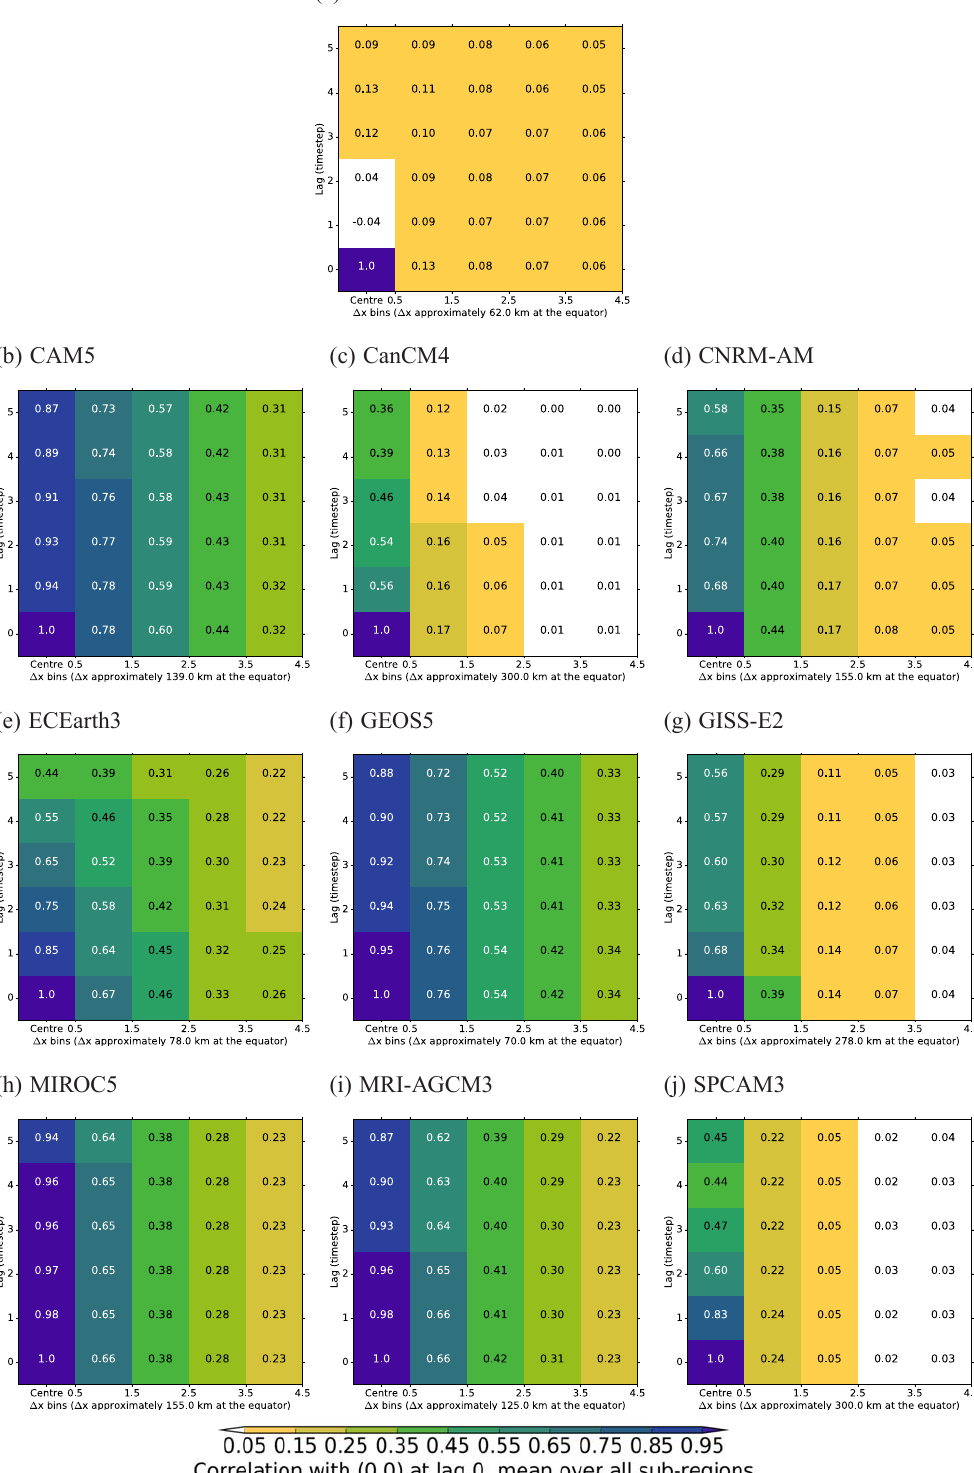
Figure 5. For each model in the GASS/YoTC dataset and using time step precipitation data on the native model grid, lagged correlations between the central gridpoint in each 7 × 7 region and gridpoints within each range of distance on the horizontal axis (in units of (cid:49)x ) away from the central point, averaged over all 7 × 7 regions. The printed values and filled blocks show the same data; “centre” in the auto-correlation at the central point. We omit the bin for points less than 0.5 (cid:49)x away from the central point, as no points in these datasets fall into that